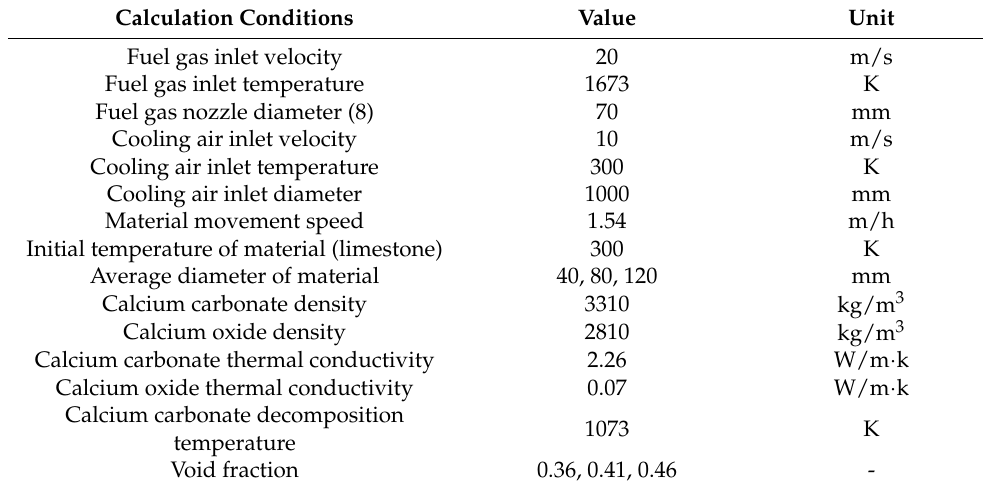
Table 1. Calculation